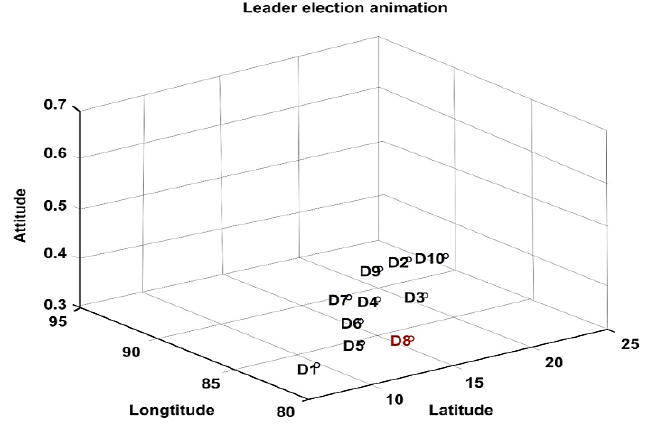
Figure 9. Network Topology with 10 drones with elected CH.